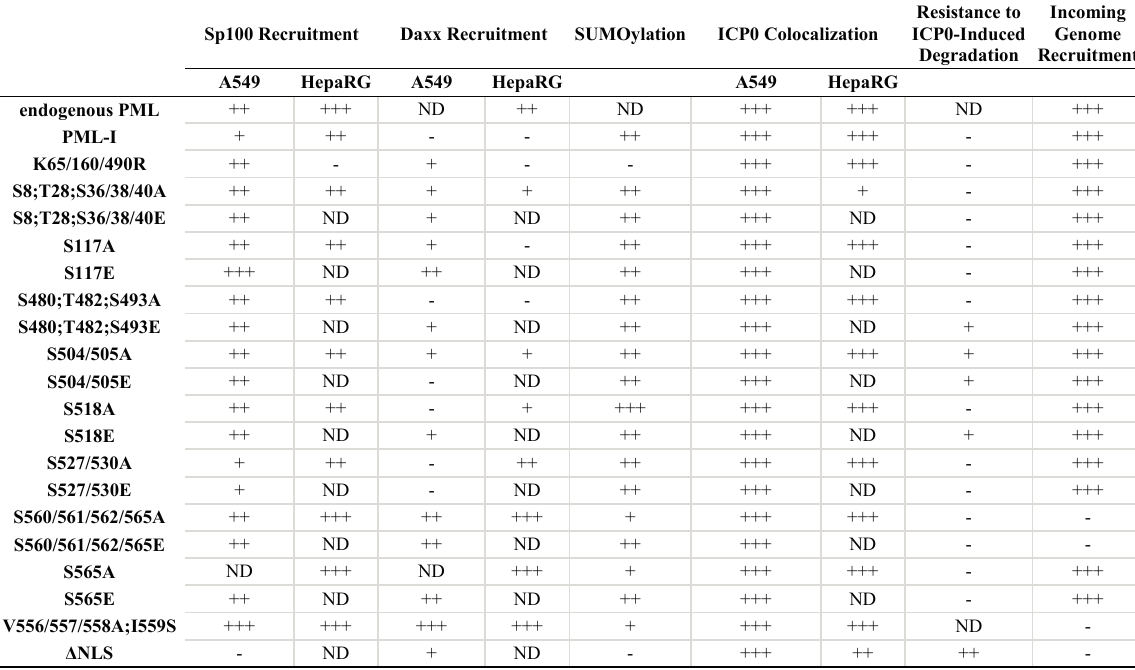
Table 2. Properties of PML-I and PML-I